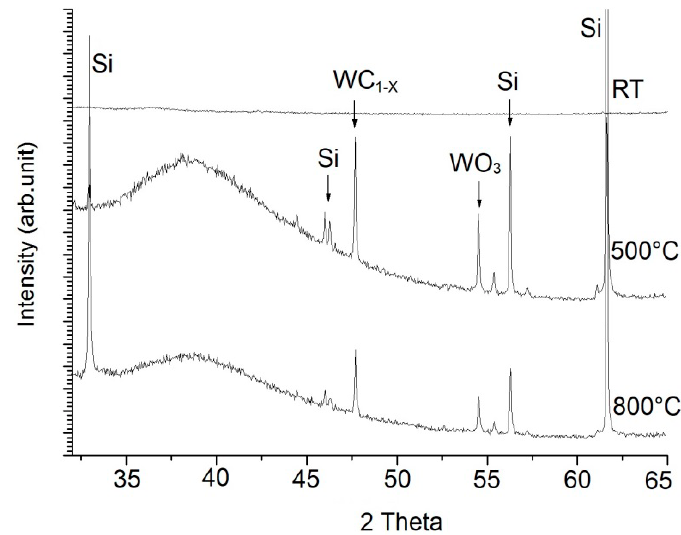
Figure 11. X-ray diffraction scans of WC/C coatings at RT, after annealing at 500 and 800 °C; Si phase.